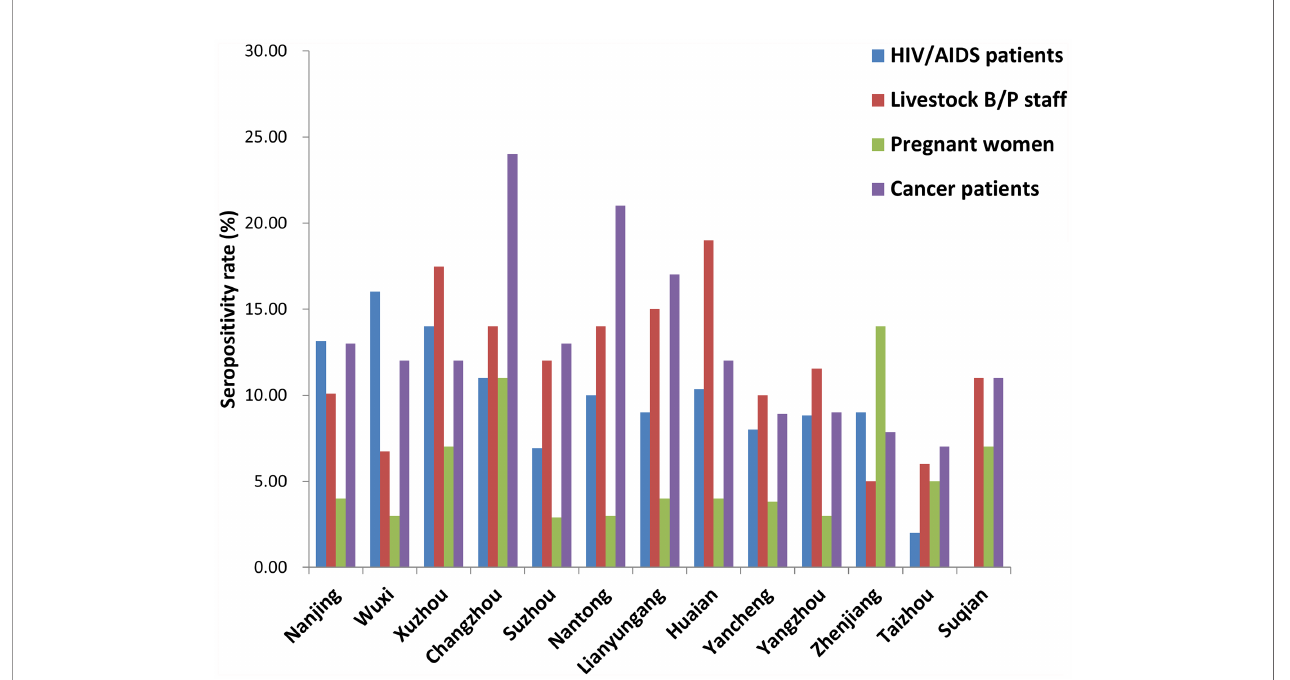
FIGURE 3 | Seropositivity rate for different high-risk populations in each city of Jiangsu Province,